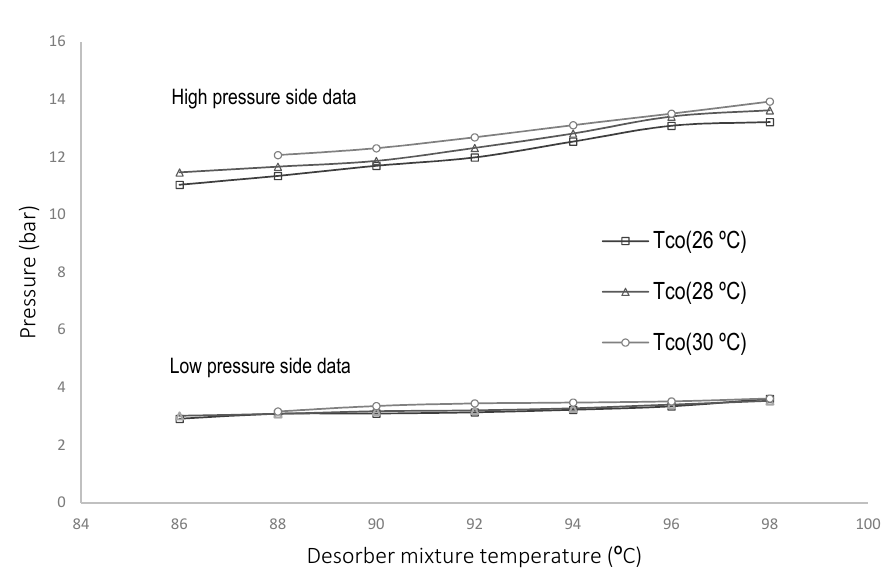
Figure 5. Main pressure profile in the DE and EV system at different T CO and T DE .